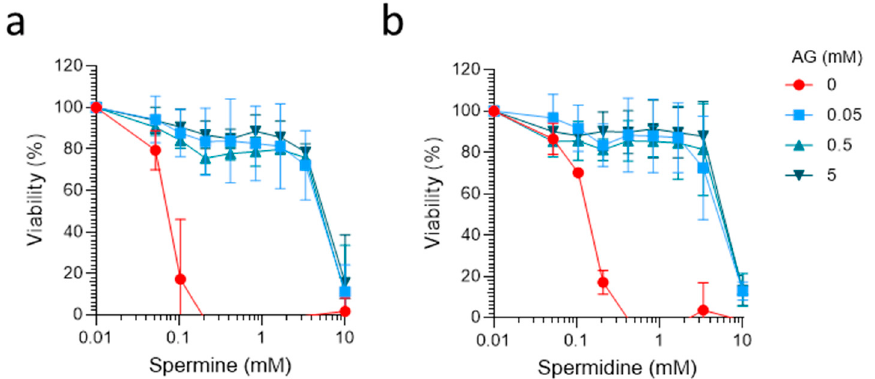
Figure 3. The diamine oxidase inhibitor aminoguanidine prevents FCS-mediated cytotoxic effects of spermine and spermidine. Here, FCS (100%) was preincubated with the indicated concentrations of aminoguanidine (AG) for 24 h. Tenfold dilutions of these samples were then used as cell culture supplement for TZM-bl cells, which were incubated with spermine ( a ) and spermidine ( b ) for 2 days. Viability was determined by MTT assay. Data shown are average % values derived from 3 individual experiments performed in biological triplicates ± SD.